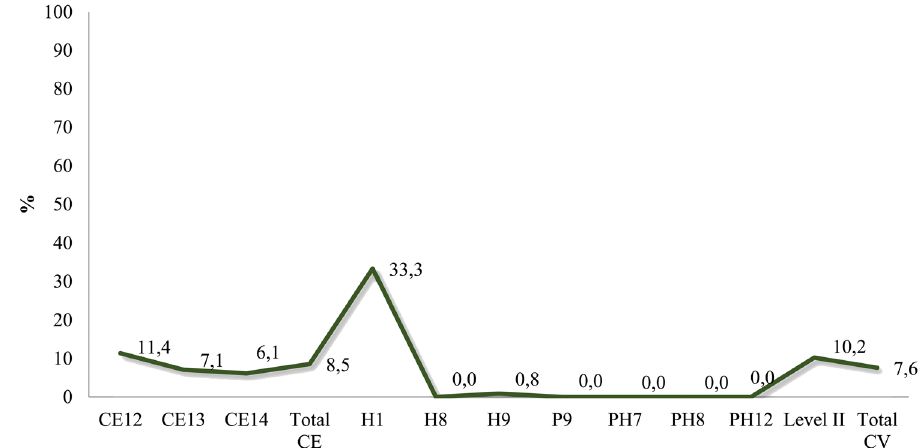
Figure 2: %Whole values by levels or